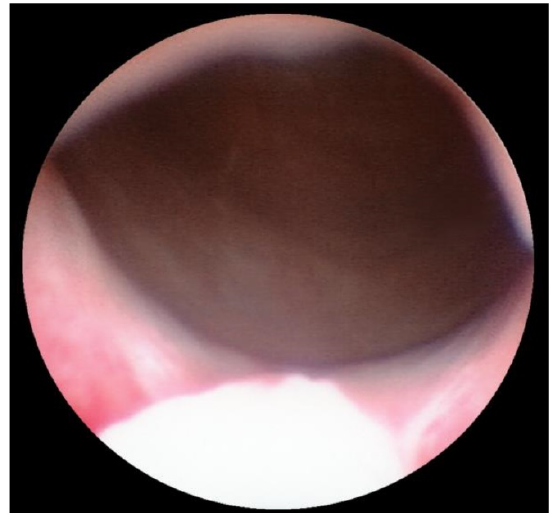
Figure 5. Transurethral cystoscopy: wide open bladder neck.